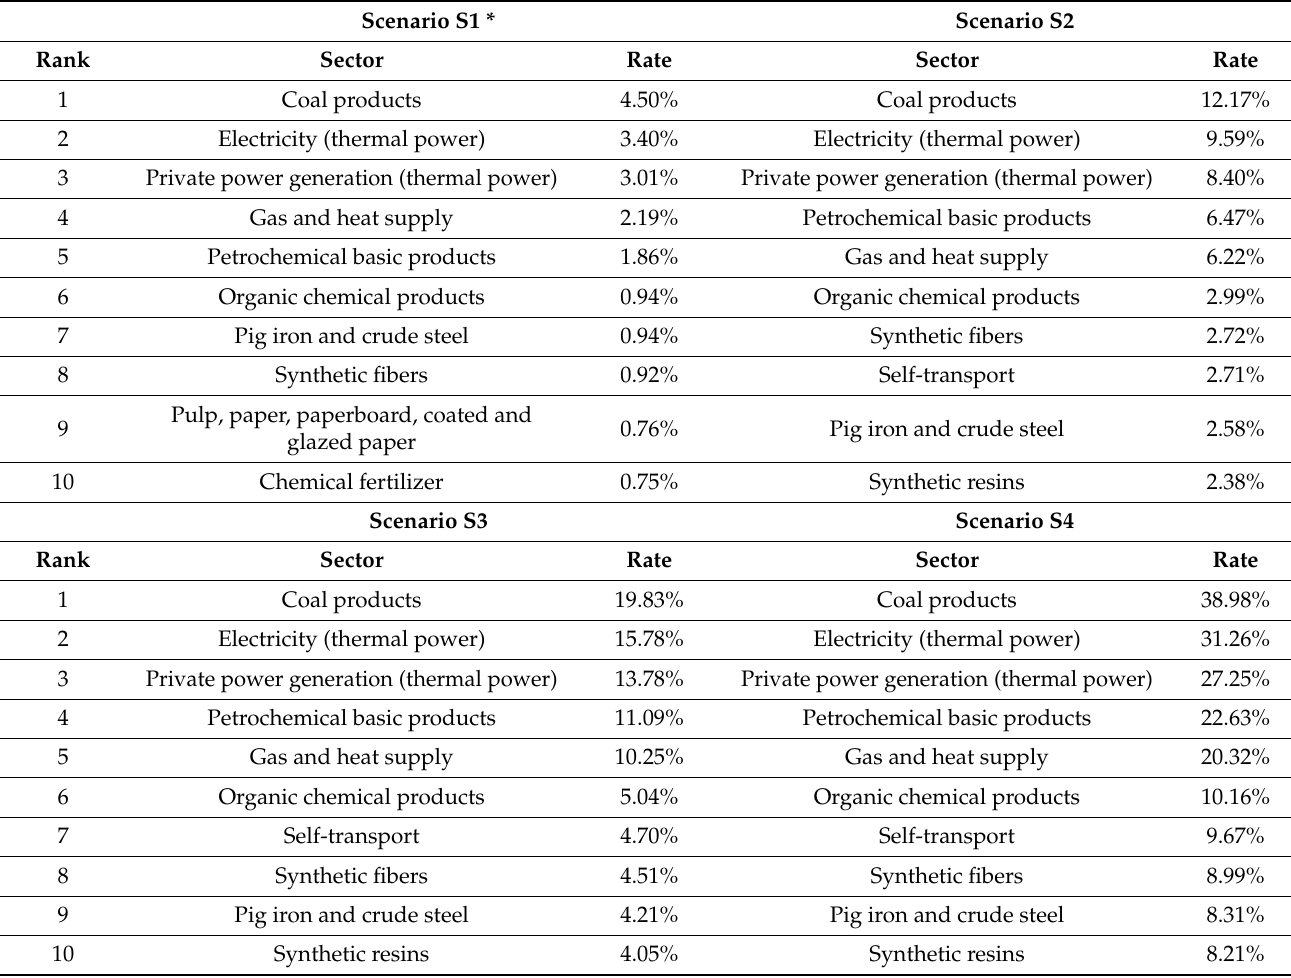
Table 6. Price increase due to the change in the main tax rate for coal and gas, and the TGWC increase (top 10 sectors, unit: